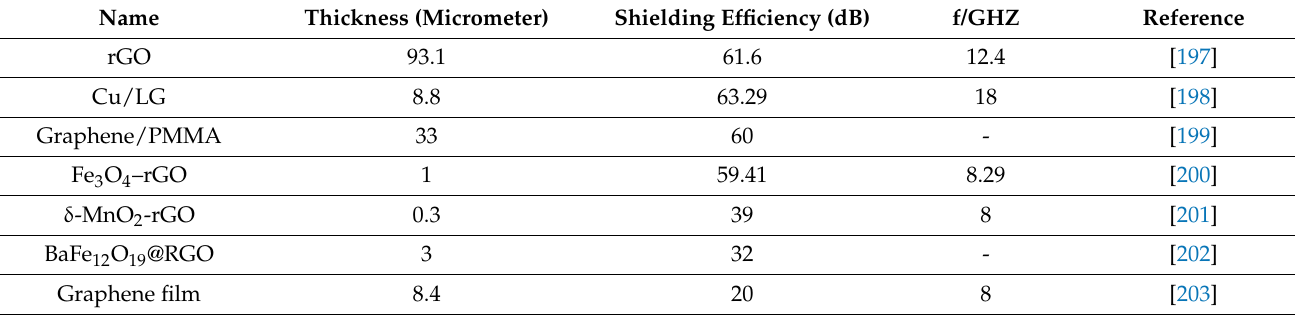
Table 6. List of graphene oxide–metal hybrids used in radiation